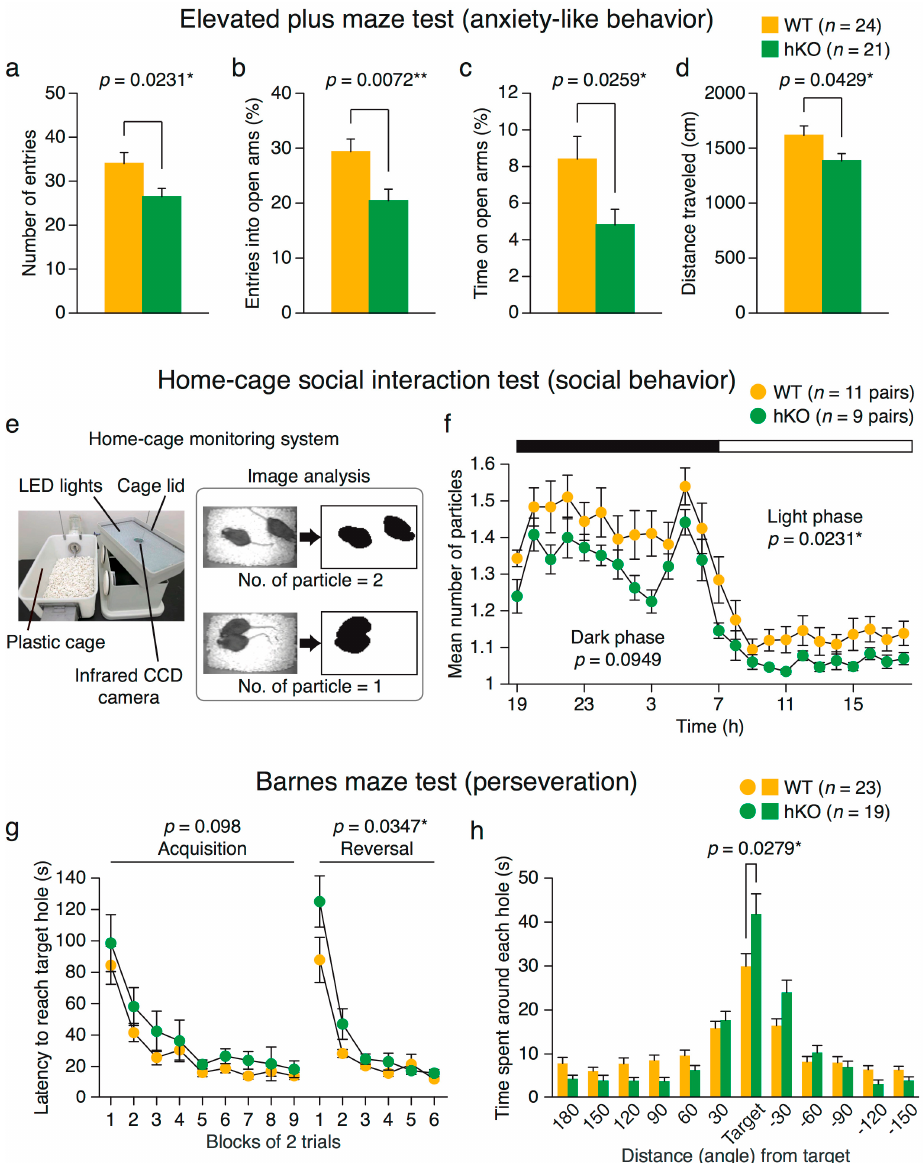
Figure 1. Anxiety-like behavior, social behavior, and reversal learning performance in Arid1b hKO mice. ( a – d ) Elevated plus maze test; ( a ) number of total entries into arms; ( b ) percentage of entries into open arms; ( c ) stay time in open arms; ( d ) total distance traveled (wild-type (WT) mice, n = 24; Arid1b hKO mice, n = 21); ( e ) home-cage monitoring system for measuring social behavior. The number of particles detected in each image was counted; ( f ) mean number of particles during each hour of the final three days in the apparatus (WT, n = 11; Arid1b hKO, n = 9); ( g – h ) Barnes maze test; ( g ) latency of first reaching the target hole across nine blocks of two acquisition trials. One day after the acquisition trials, a probe test was performed in which the target box was removed. After the probe test, the target was located on the opposite side to assess reversal learning; ( h ) stay time around each hole in the probe test held a day after completion of the first training. (WT, n = 23; Arid1b hKO, n = 19). Significant differences between genotypes are indicated by * p < 0.05 and ** p < 0.01, as determined by Student’s two-tailed t -test ( a – d , h ) or two-way repeated-measures analysis of variance (ANOVA) ( f , g ).